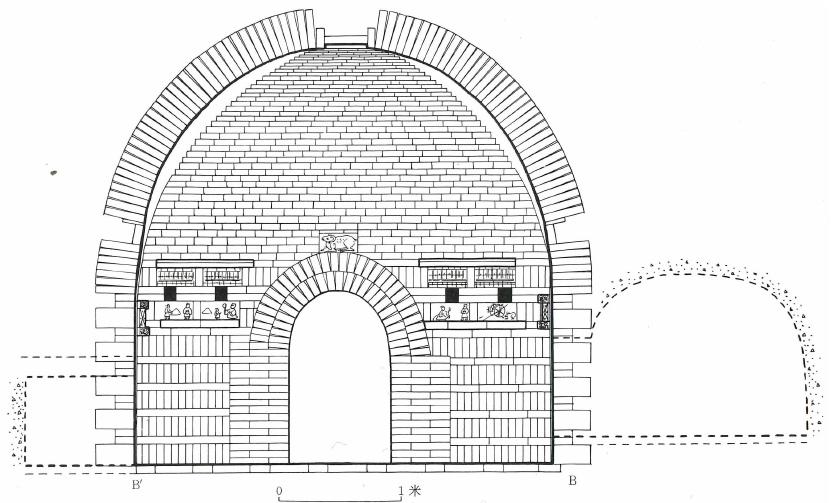
Figure 12. West wall of Foyemiaowan M39, brick, Western Jin period (265–317). (Gansusheng Wenwu Kaogu Yanjiusuo 1998, Figure 6). ©Wenwu Press. This figure published with permission of Wenwu Press and cannot be used or copied without their permission.